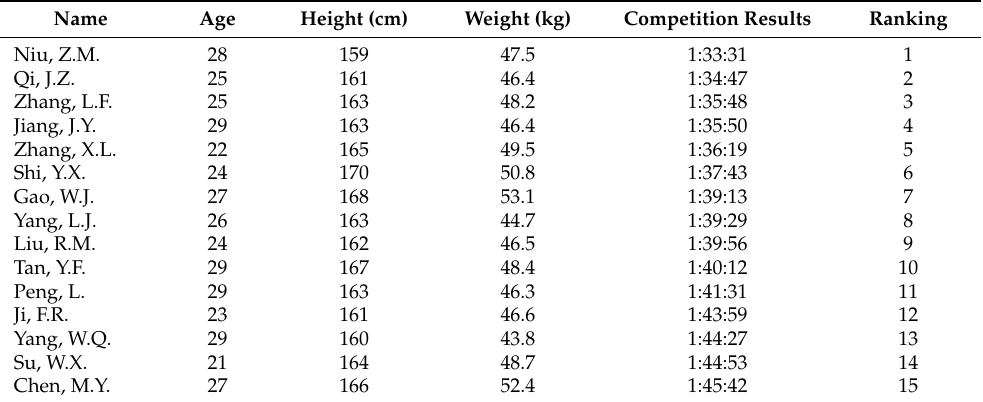
Table 1. Basic information on the chosen subjects * ( N = 15 ).